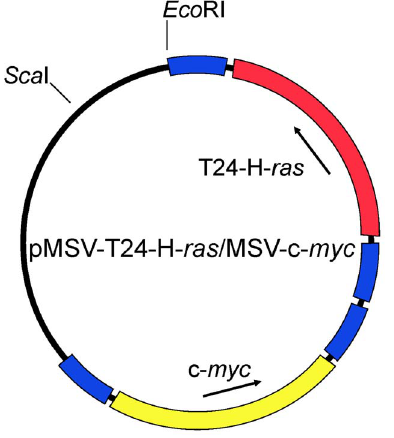
Figure 1. Structure of pMSV-T24-H-ras/MSV-c-myc. The human T24-H- ras gene is shown in red, the murine c- myc gene is shown in yellow, the MSV LTR elements are shown in blue.